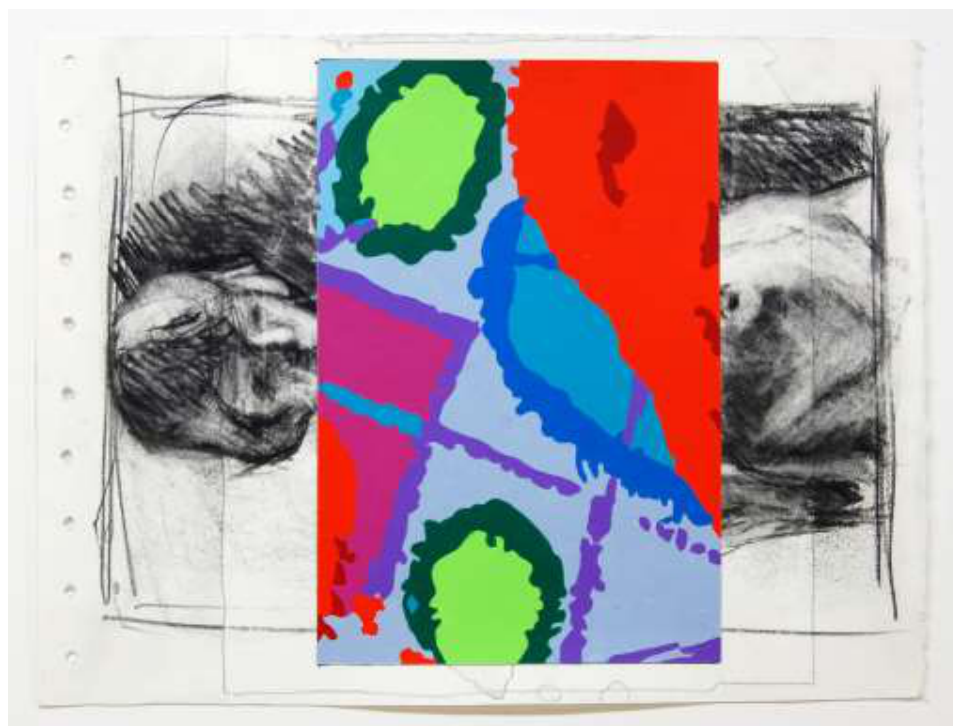
Steven Pearson, Sketchbook Revisions: Plaster Model (Vertical) , 2014, charcoal, graphite, and acrylic on Rives BFK, 12 x 9